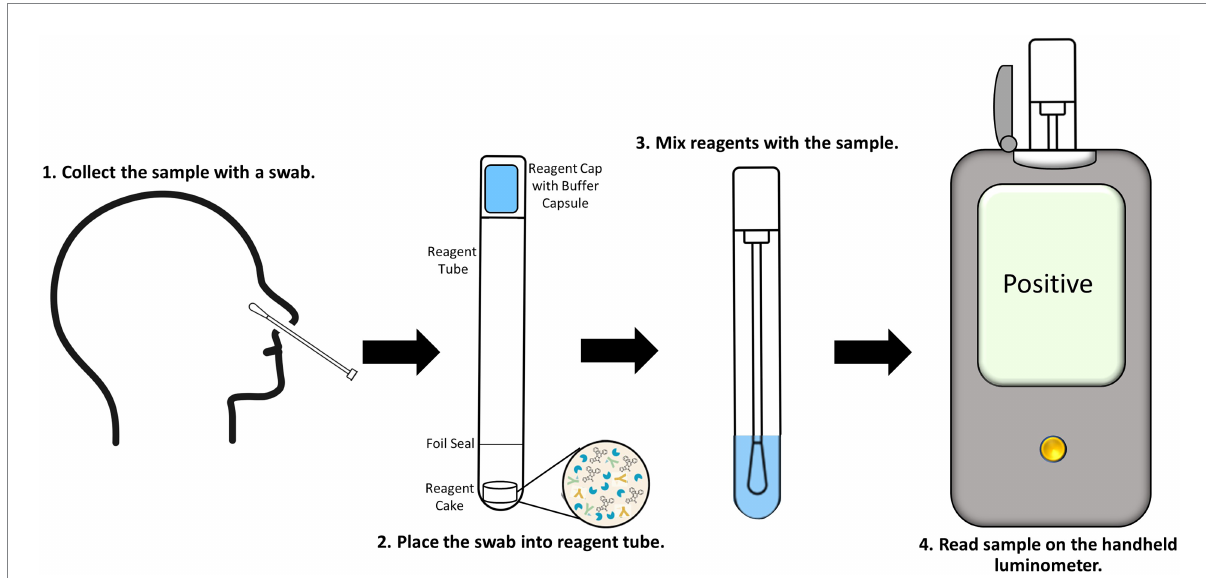
FIGURE 5 Proposed workflow for the point-of-care SARS-CoV-2 antigen immunoassay utilizing the ternary Nluc reporter system. Nasal swabs are collected (1) and placed into the reagent tube, breaking through the foil seal to expose the reagent cake (2). The cap is placed and locked onto the tube containing the sample. The buffer capsule in the cap is then cracked and the tube is shaken to reconstitute the cake and mix the assay reagents with the sample (3). The tube is then inserted into the handheld luminometer and read